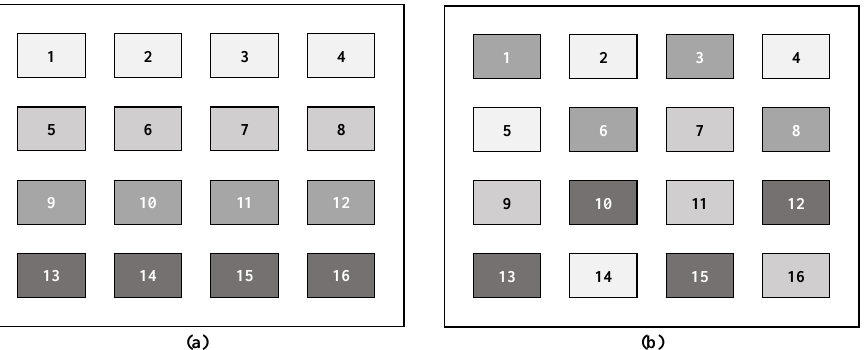
Figure 2. ( a ) General grouping; ( b ) proposed grouping; the numbers in the figure indicate the index of RIS